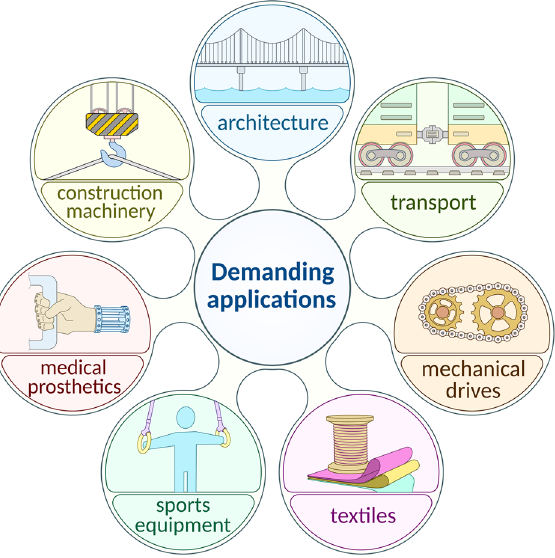
Figure 1. A basic chart of important applications of nondestructive analysis of mechanical